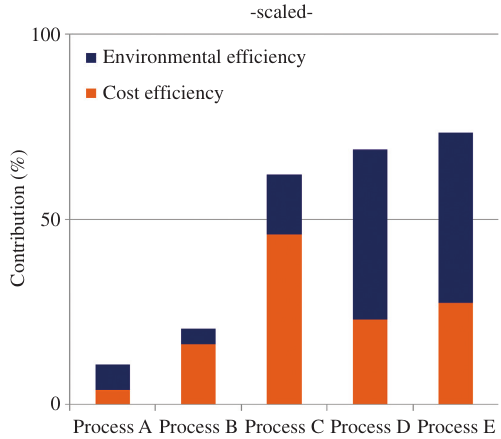
Figure 14 Criteria contribution on overall eco-efficiency ranking of different biodiesel process alternatives utilizing waste oil (Process A: pretreated alkali-catalyzed; Process B: acid-catalyzed; Process C: heterogeneous acid-catalyzed; Process D: supercritical process, all published by West et al. [42] and Process E: supercritical process developed within